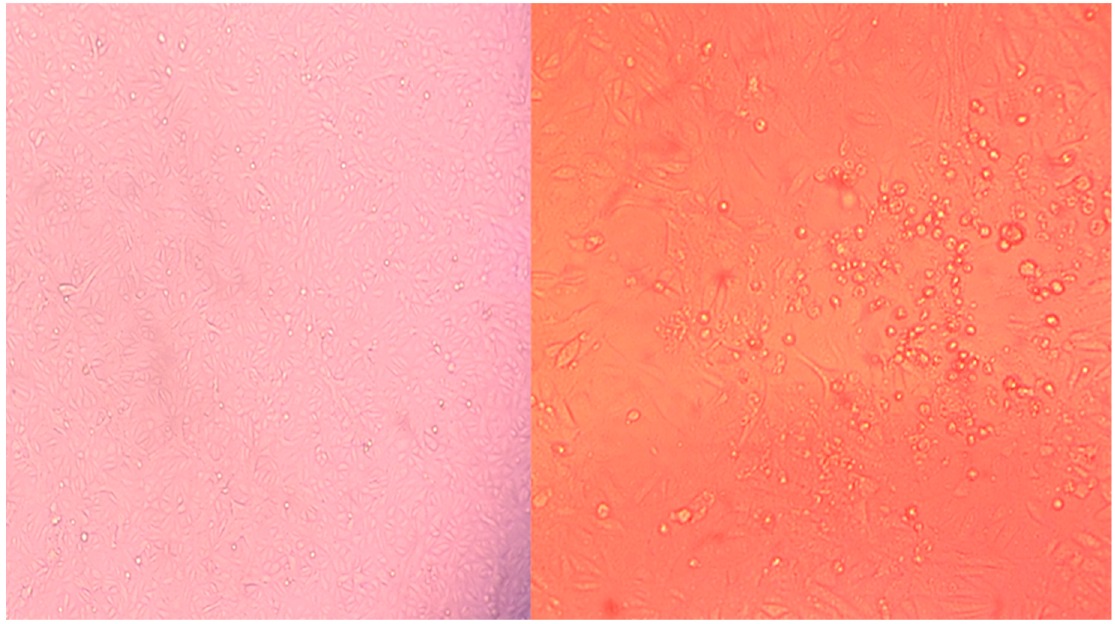
Figure 1. Cell cultures illustrating cytopathic effect (CPE) in the sequenced culture with Moskva (right) relative to the control (left).